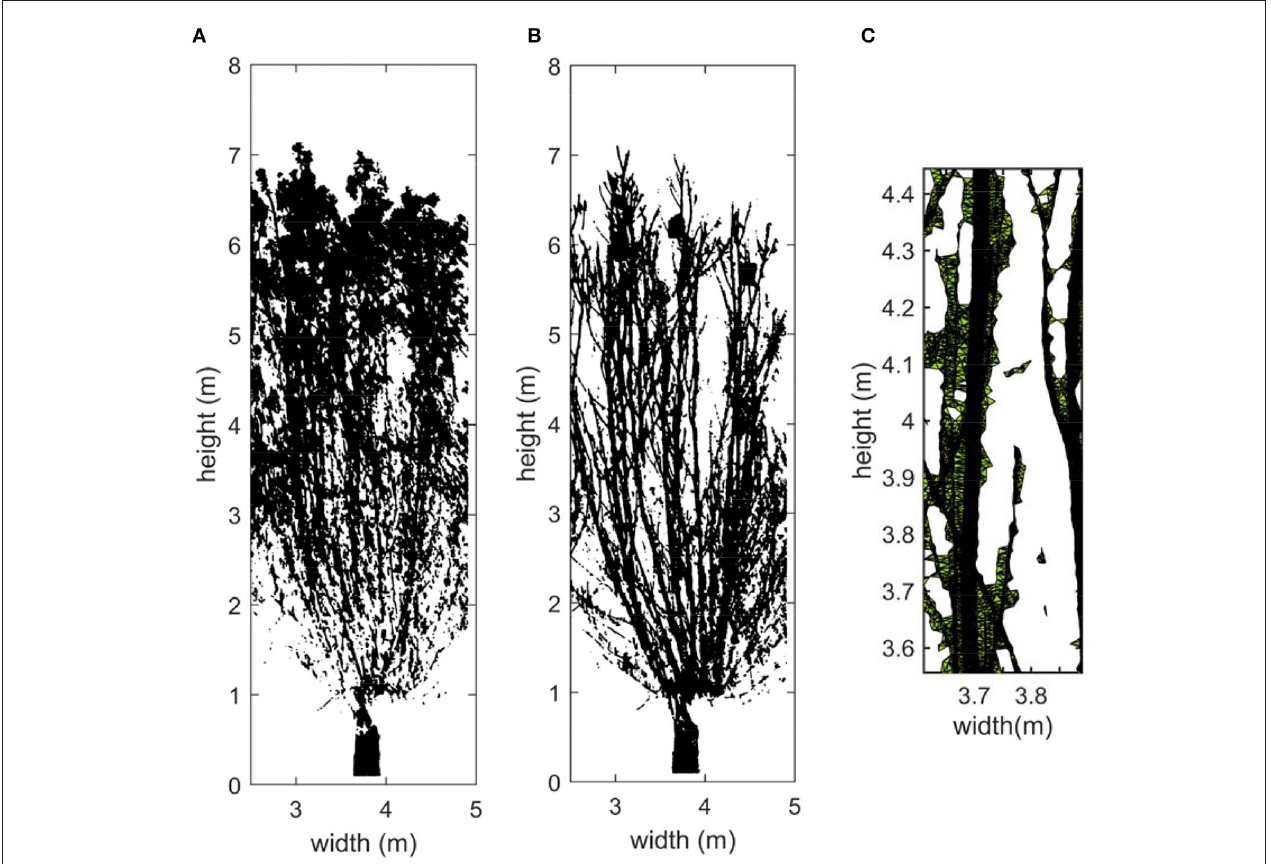
FIGURE 6 | (A) Tree A1 with leaves, (B) tree A1 without leaves, (C) surface area by alpha shape function ( α